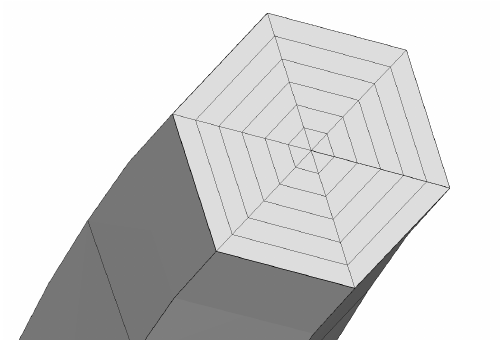
Figure 5. Detailed view of the